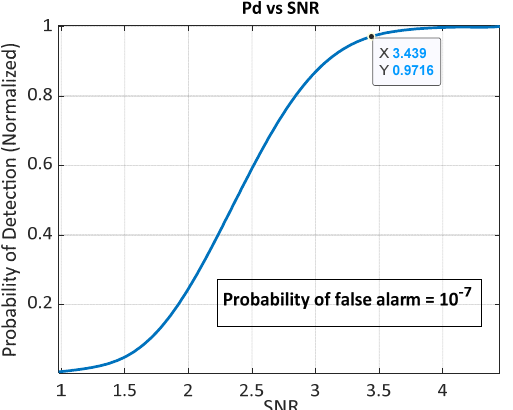
Figure 7. Normalized probability of detection versus signal-to-noise ratio (SNR, linear scale) which was obtained as a result of Monte Carlo simulation of the algorithm used.